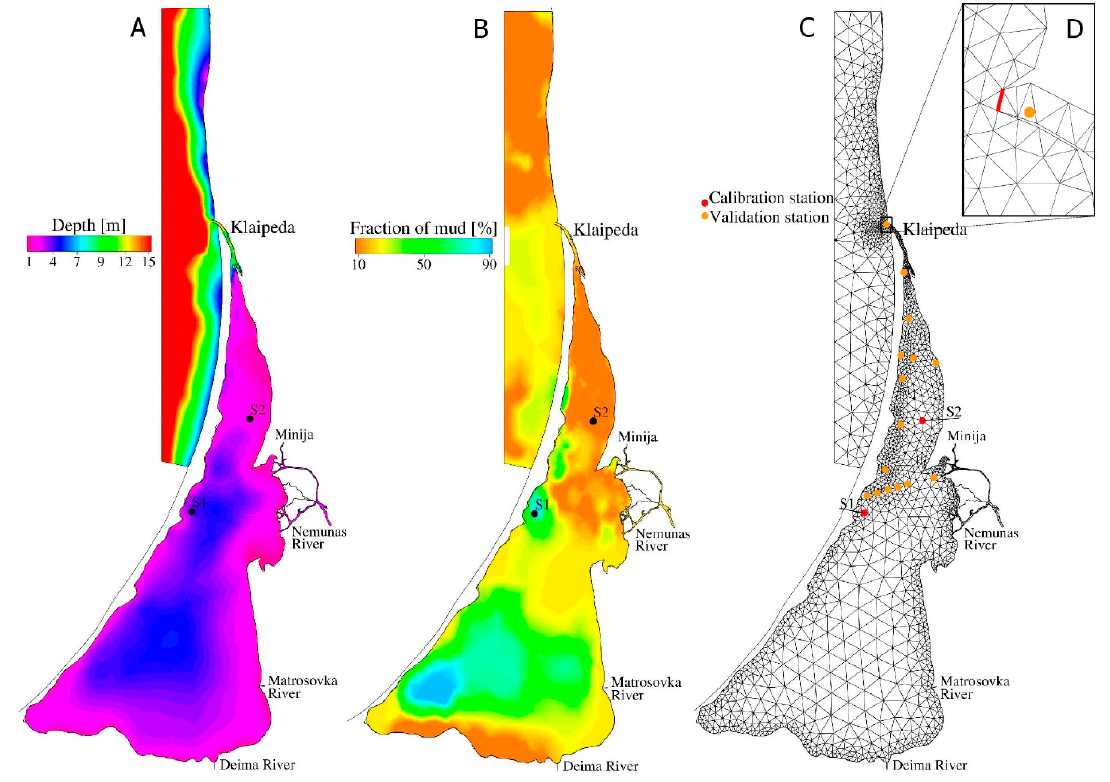
Figure 2. ( A ) Initial bathymetry; ( B ) initial bottom sediment composition; ( C ) computational grid with validation stations and calibration stations (S1 and S2); ( D ) the flux section for the sediment budget